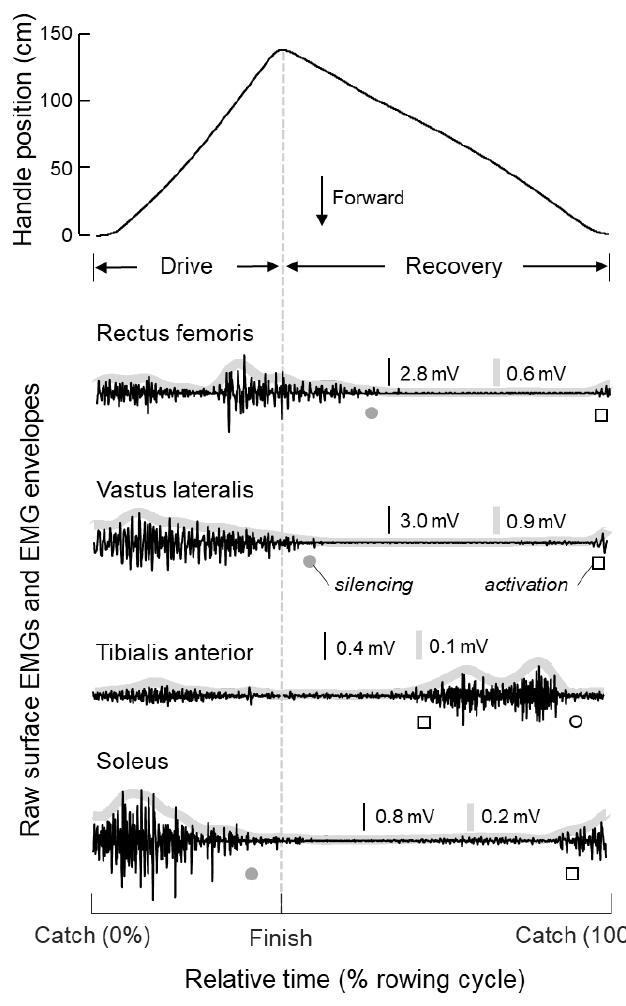
Figure 1. Position of the handle of the rowing machine (top) and raw surface electromyograms (EMGs) (black traces) are shown for a single subject and rowing cycle. EMGs were detected, from top to bottom, from the rectus femoris, vastus lateralis, tibialis anterior, and soleus muscles of the left body side. Grey traces superimposed on the raw EMGs denote EMG envelopes (cf. Methods). Instants corresponding to the onset of activation (squares) and to the onset of silencing computed for the current (white circle) and for the preceding rowing cycle (grey circle) are shown just below to each EMG trace. Time is represented in relative units, with respect to the rowing cycle, with the vertical dashed line indicating the finish instant.